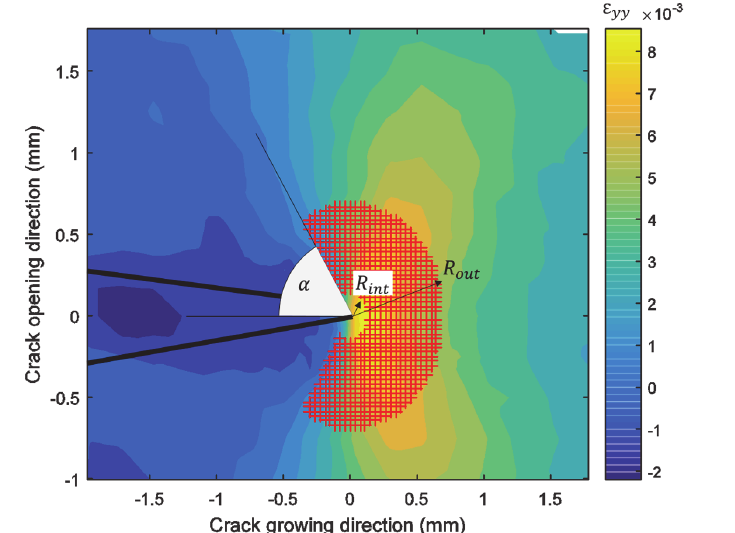
Figure 2: The elastic strain field based on the (211) peak local to the crack in the crack opening direction ( ε yy ) for a 13 mm crack length subjected to 5.3 kN. The area sampled by each point is 60 x 60  m. The parameters relating to the area of interest are also illustrated: inner radius of the data array, R int , outer radius of the data array, R out , and angle between the end of the data array and the crack plane, α